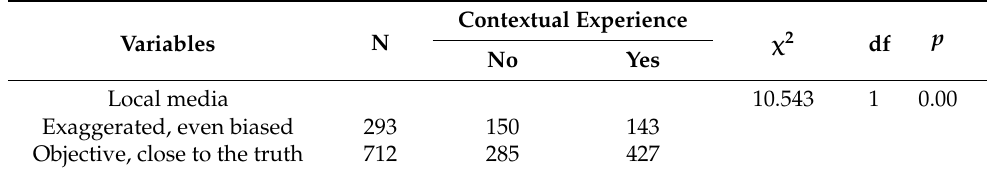
Table 7. Table of associations: Personal involvement in the fight against COVID-19—contextual experience/appreciation of the local media.